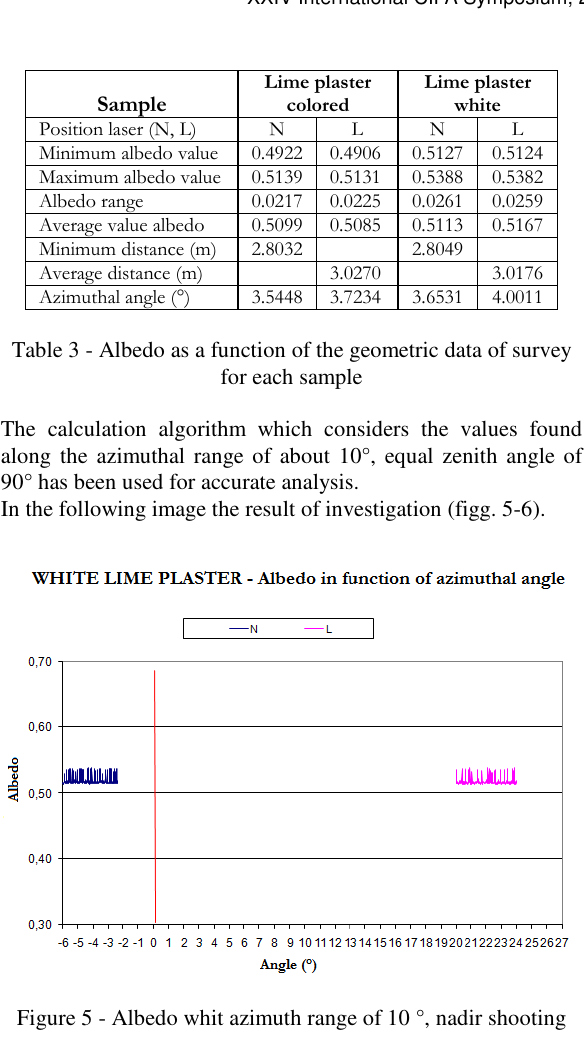
Figure 7 – Albedo in function of the degree of crystallinity